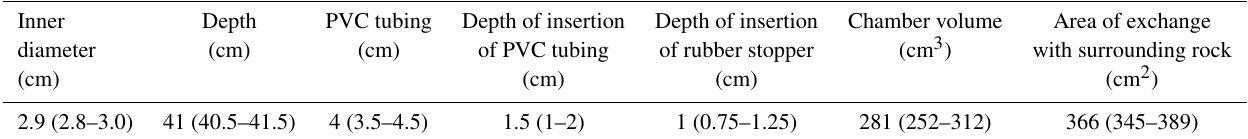
Table 1. Dimensions of a typical chamber, given as ranges: median (minimum–maximum). Chamber H6 was drilled on 13 December 2016 in the catchment of the Laval stream (Draix, France; 44.14061 ◦ N, 06.36289 ◦ E).